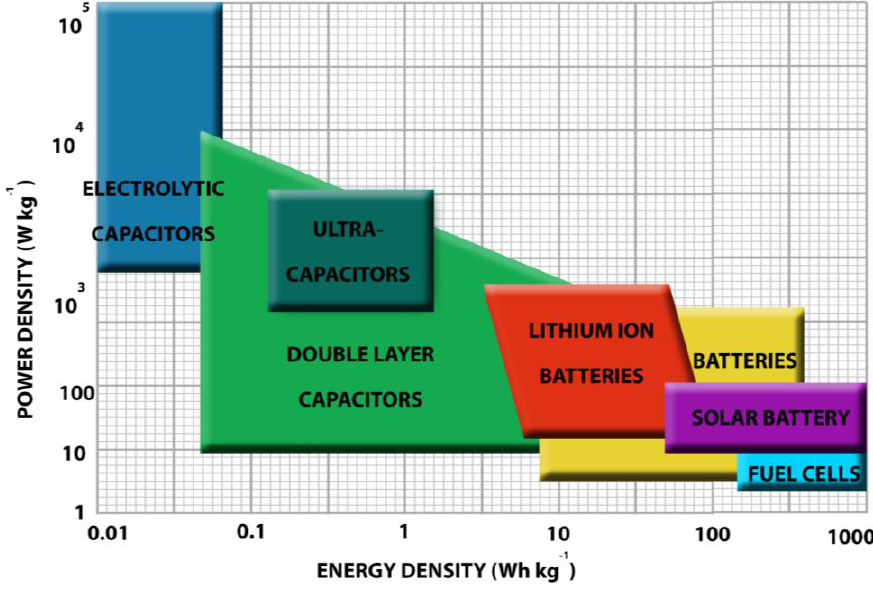
Figure 1. Ragone Plot depicting energy vs. power densities of common power